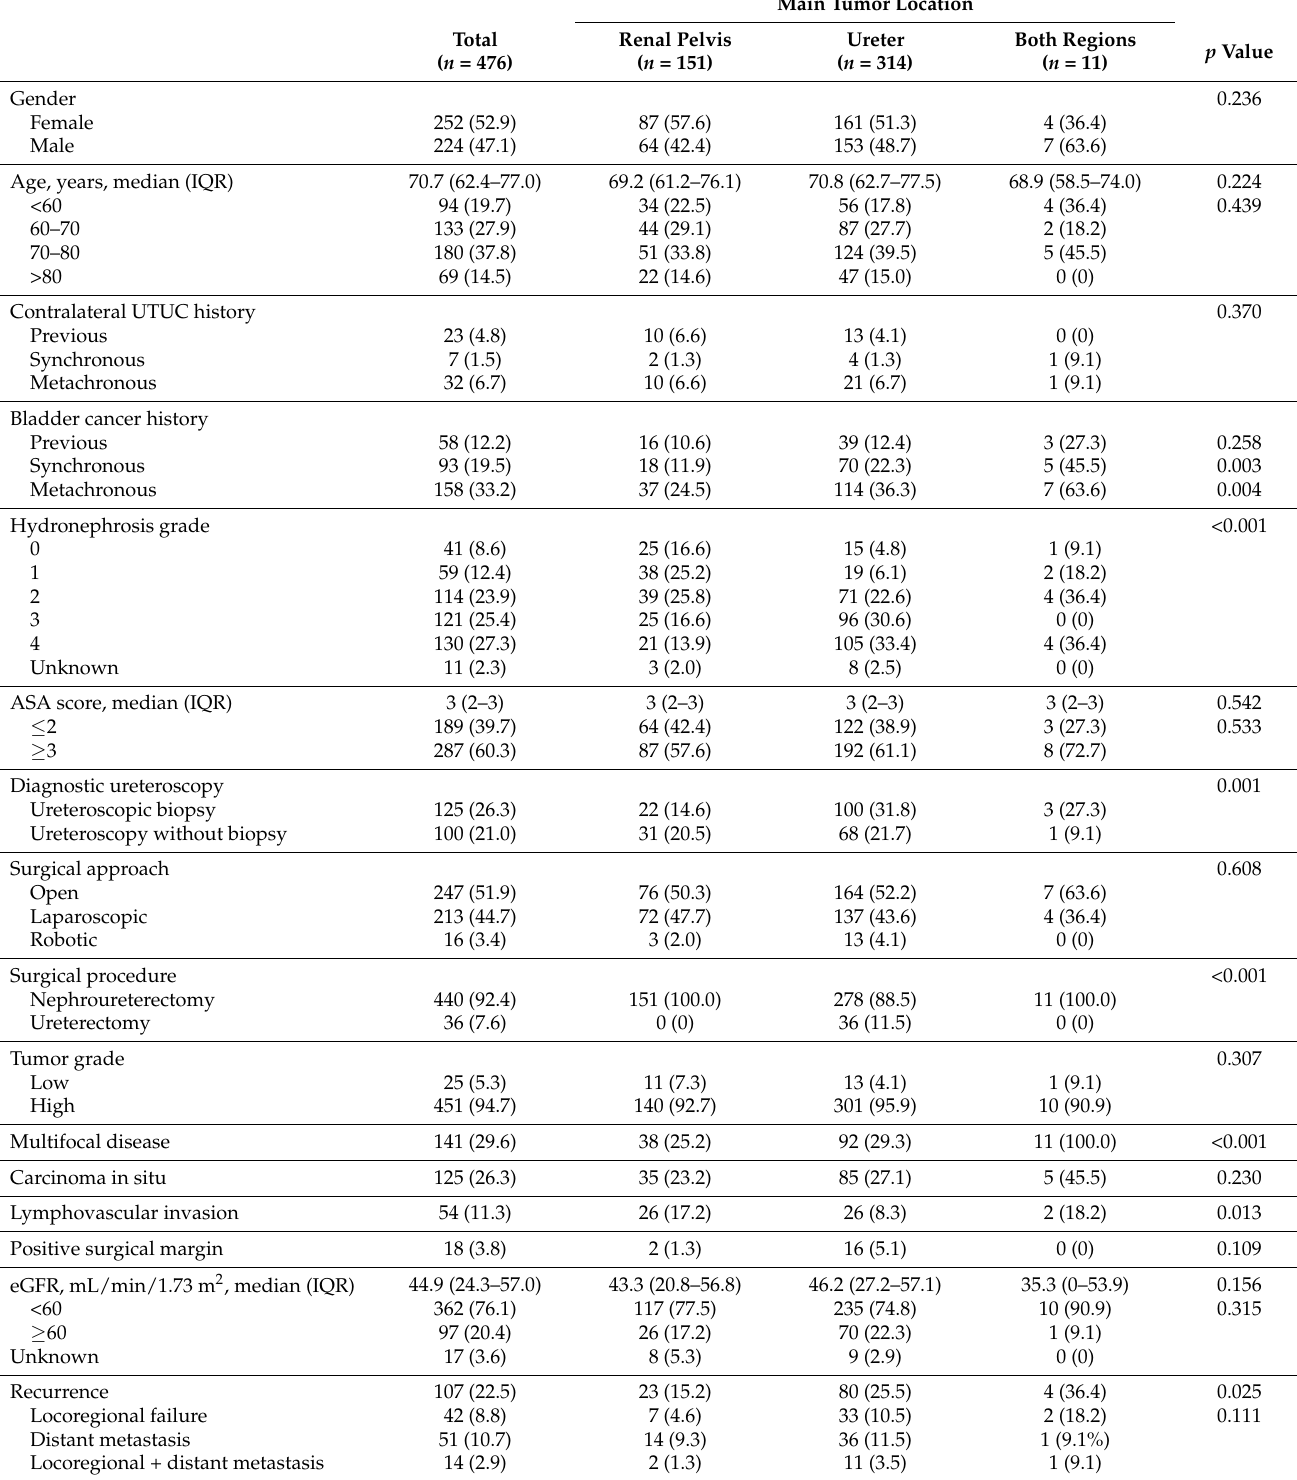
Table 1. Clinical and pathological